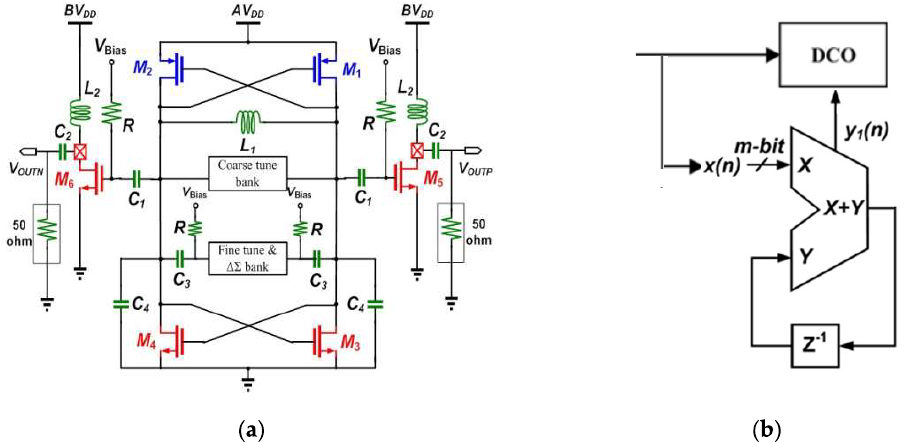
Figure 2. The proposed ( a ) LC-Tank VCO circuit; and ( b ) structure of the first-order delta- sigma